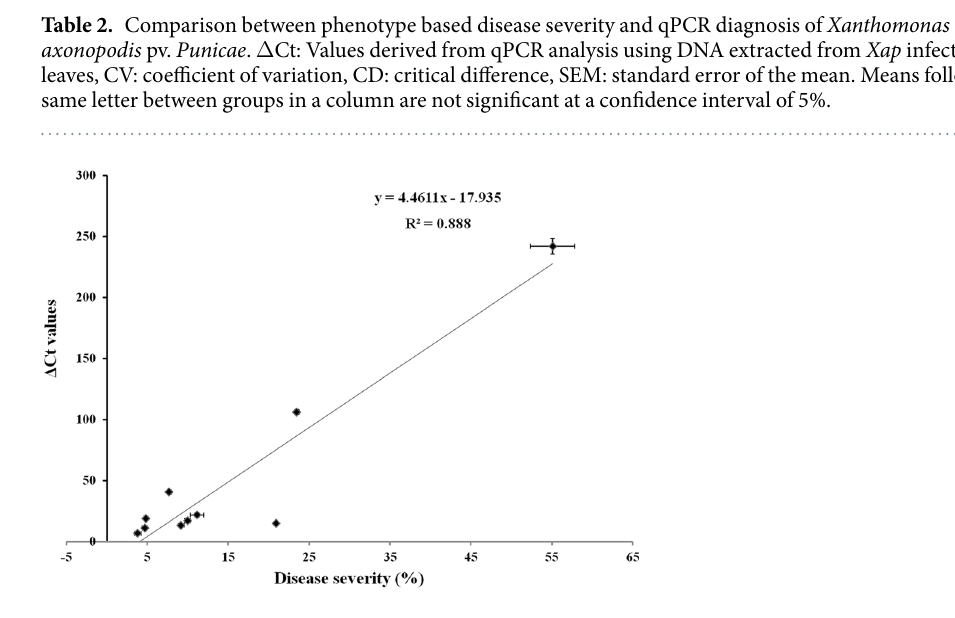
Figure 4. Comparison of pomegranate bacterial blight diagnosis by visual symptoms based disease severity and qPCR. Correlation between visual symptoms based disease severity (%) and qPCR ( Δ Ct